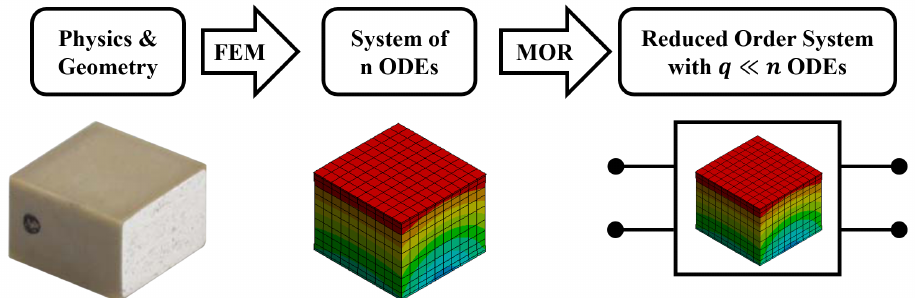
Figure 4. Schematic workflow of MOR, illustrated for the Thorlabs PA3JEAW piezoelectric